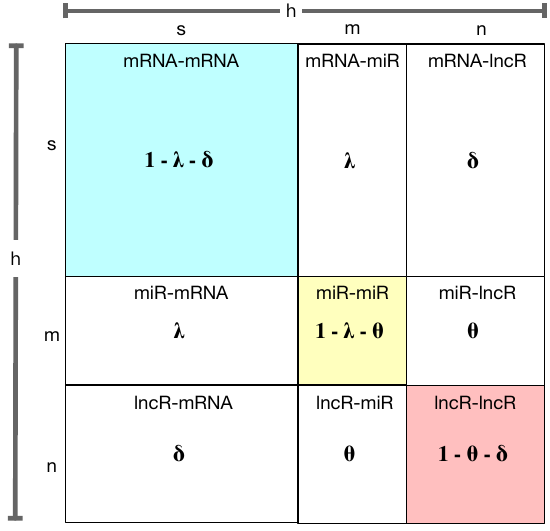
Figure 3. This is a diagram of the transition matrix calculation. Nine sub-matrices form a complete transition matrix. λ is the transfer parameter between mRNA and miRNA, δ is the transfer parameter between mRNA and lncRNA, and θ is the transfer parameter between miRNA and lncRNA. The transfer parameters in each small square correspond to the parameters that could be used to calculate the percentage of summarized weight corresponding to the sub-transition